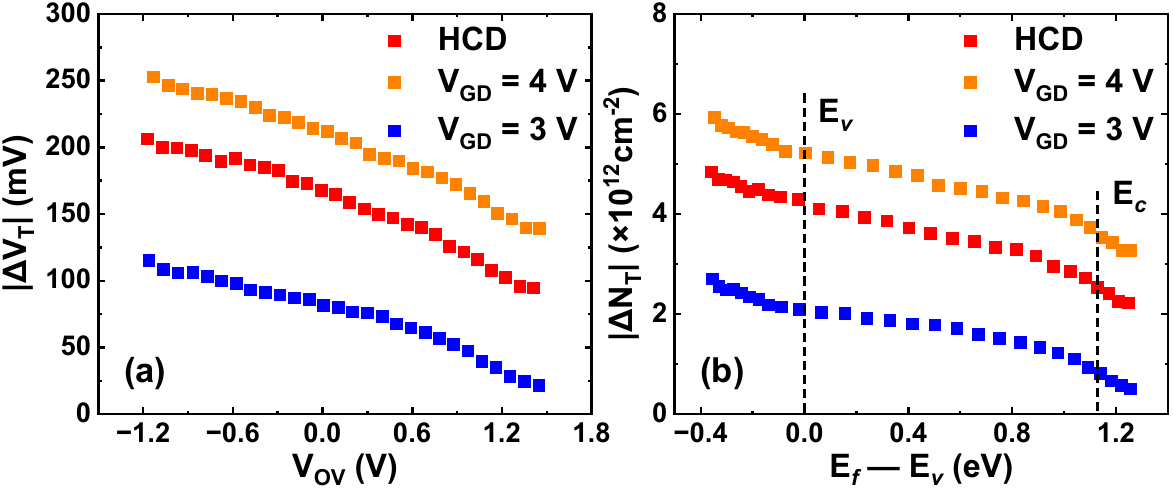
Figure 9. Extracted ( a ) Δ V T ~ V OV and ( b ) Δ N T ~ (E f —E v ) relationships after applying a new round of HCD stress to recovered devices by different GIDL biases. V GD = 3 V: V G,GIDL = 0.5 V, V D,GIDL = − 2.5 V. V GD = 4 V: V G,GIDL = 1.5 V, and V D,GIDL = − 2.5 V.